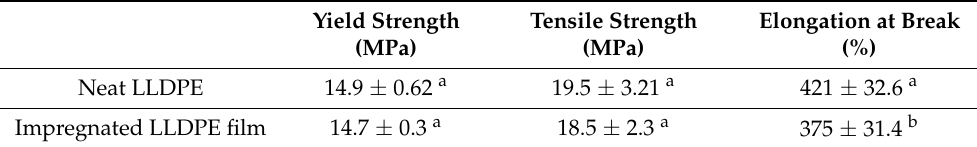
Table 7. Mechanical properties of the neat LLDPE film, and impregnated LLDPE film. Yield Strength